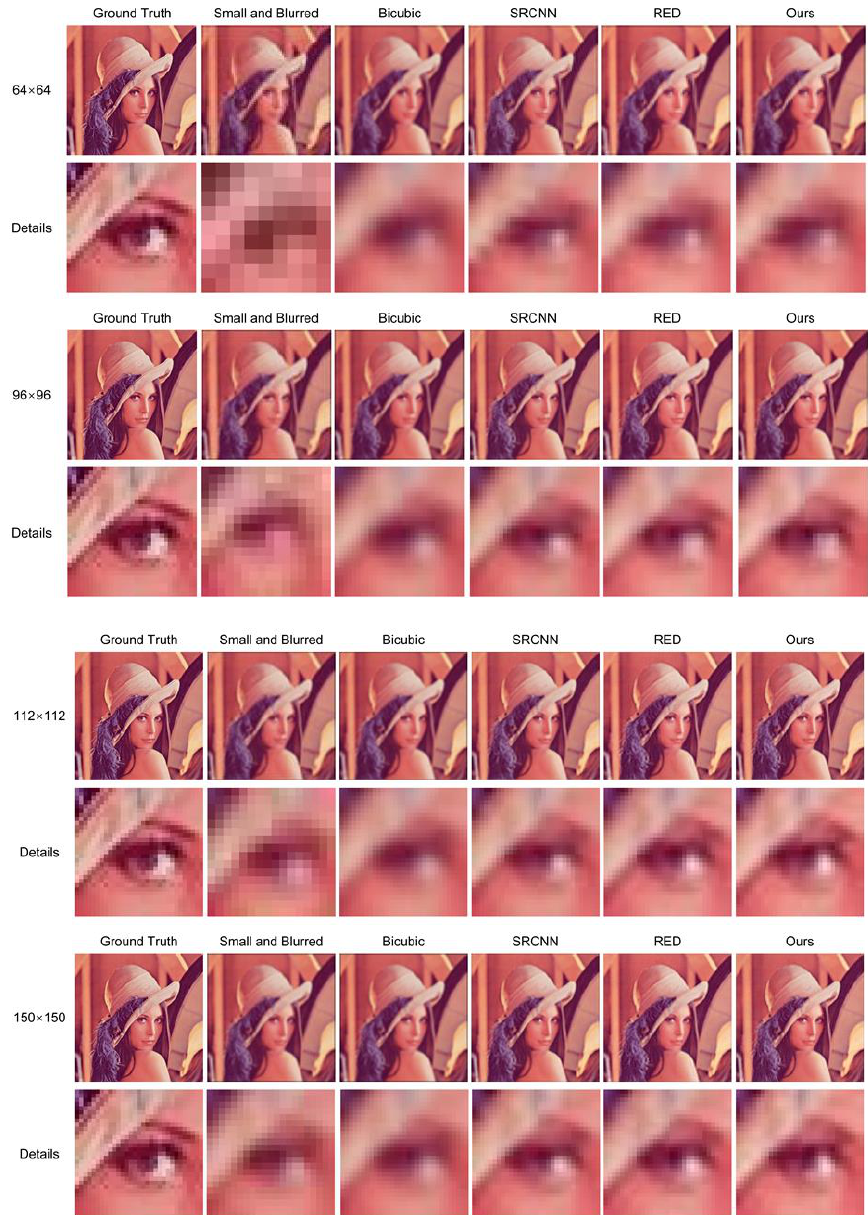
Figure 5. Visualization result with 64 × 64, 96 × 96, 112 × 112, and 150 × 150 blurred images. The details of images were highlighted.